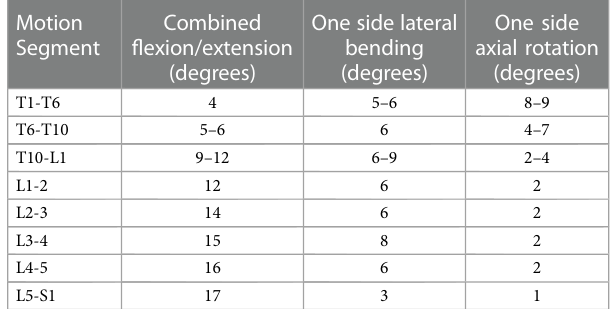
TABLE 1 Representative values for range of motion of the thoracic and lumbar spine (8).